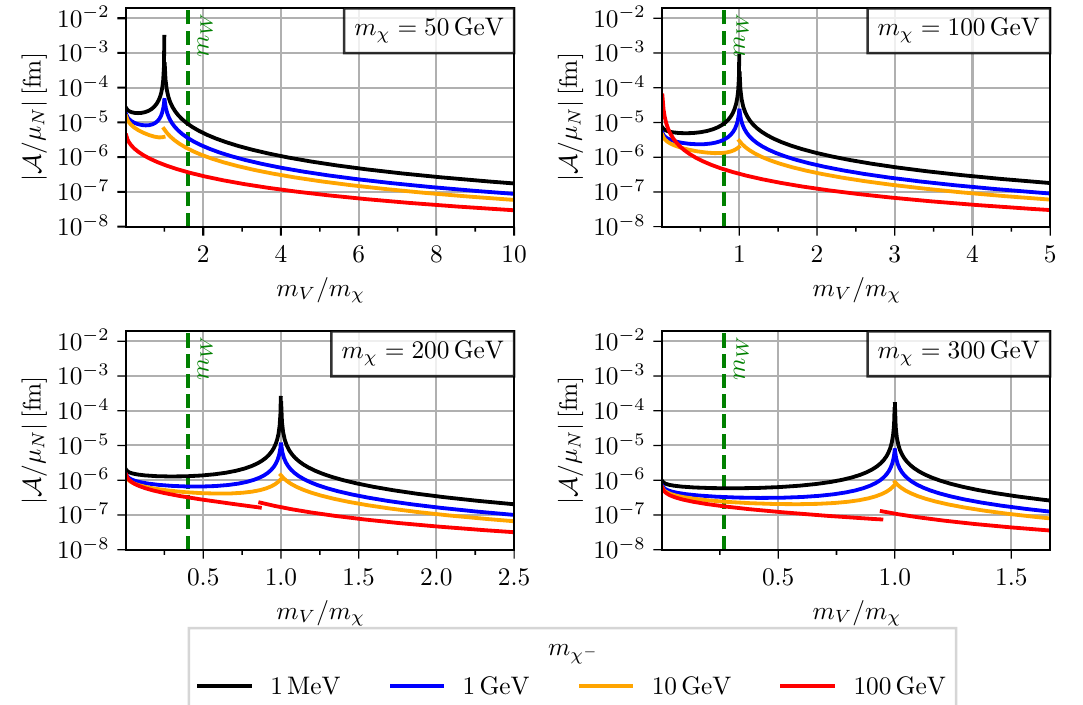
Figure 3. Anapole moment (normalized to the nuclear magneton µ N ) induced at the one loop level via the interaction of the Majorana fermion χ with a charged gauge boson V and a charged fermion χ − , as a function of m V /m χ , for different values of the Majorana mass and different values of the charged fermion mass. For the plot, we assumed for concreteness v L = 1 and v R , c G